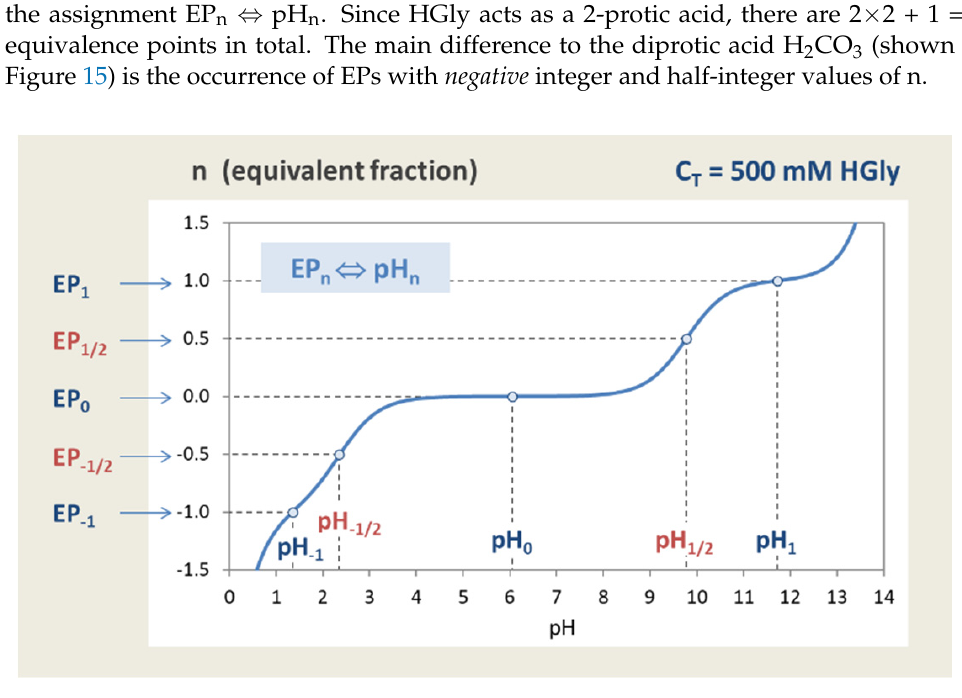
pH–C T diagrams are obtained after rearranging of Equation (139) to the form: